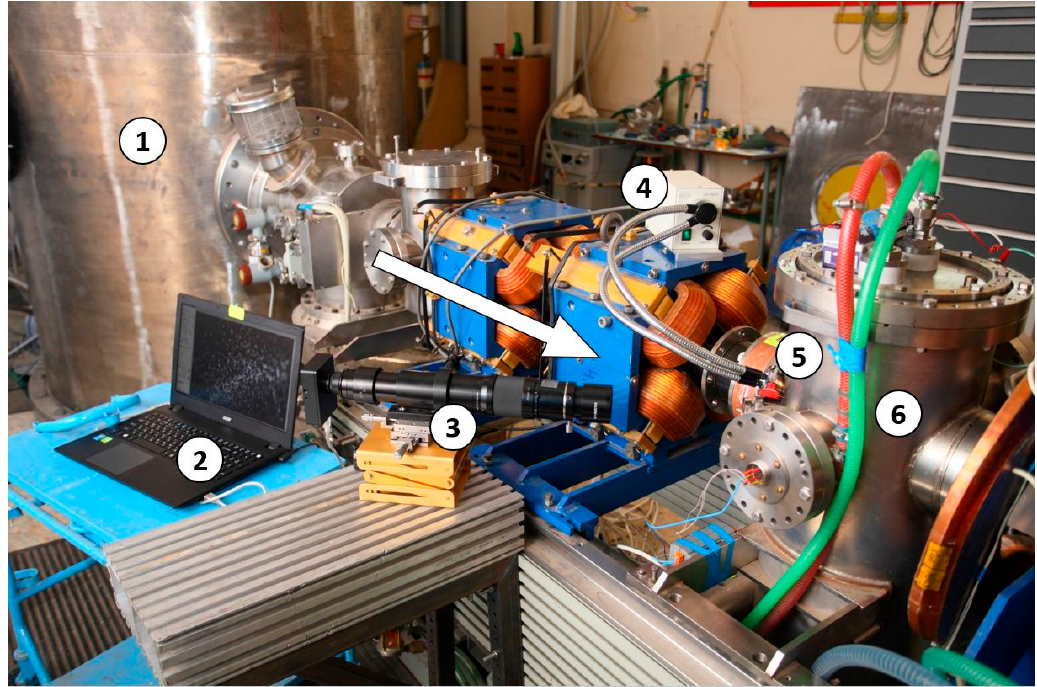
Figure 1. Experimental apparatus: ① , tandem accelerator with vacuum insulation; ② , computer; ③ , remote microscope with a charge-coupled device camera; ④ , booster-light; ⑤ , fused quartz window; and ⑥ , diagnostic vacuum chamber. The arrow schematically shows the direction of 2-MeV proton beam propagation.